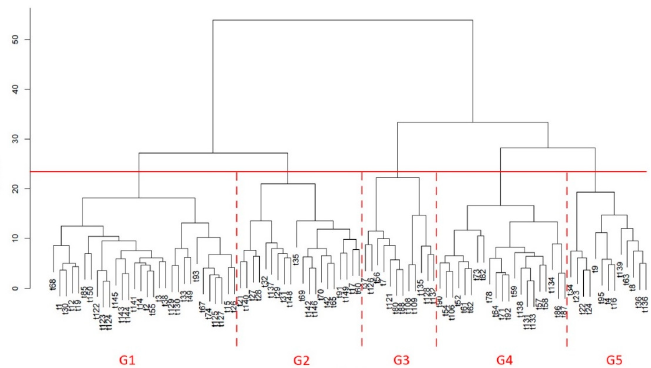
Figure 1. Dendrogram with the identification of five clusters/groups (G1, G2, G3, G4 and G5), for a Euclidean distance from 0 to 25, based on the dissimilarities of the sensory profiles of oils obtained from centenarian olive trees grown in the Côa Valley region.